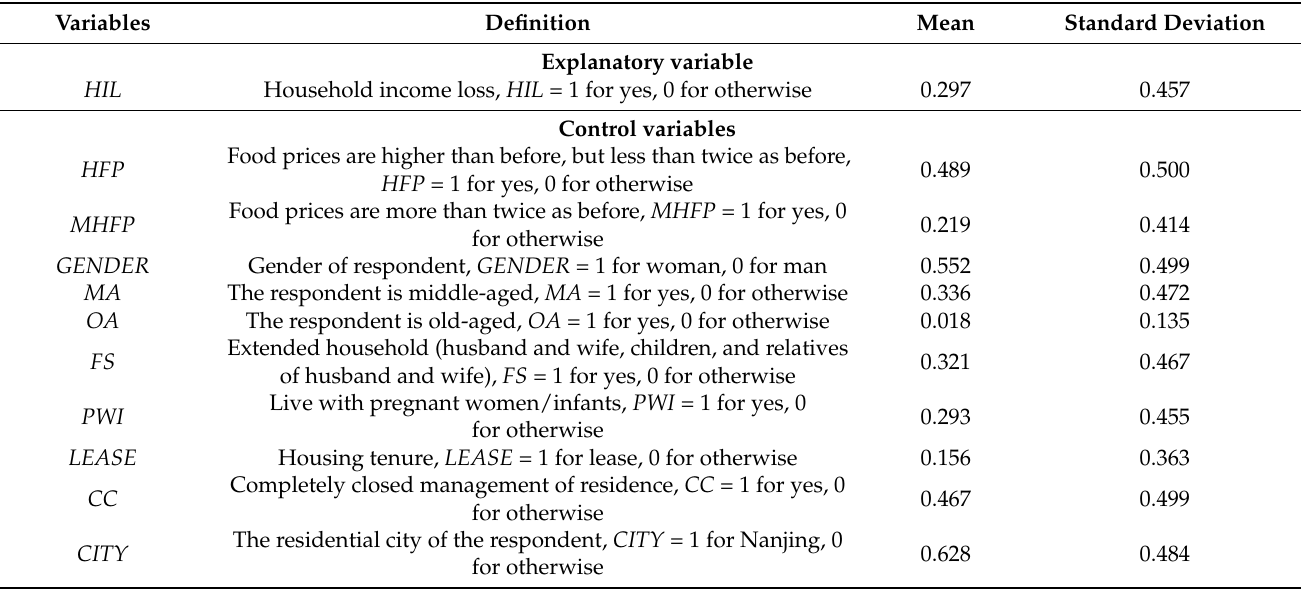
Table 2. Definition of independent